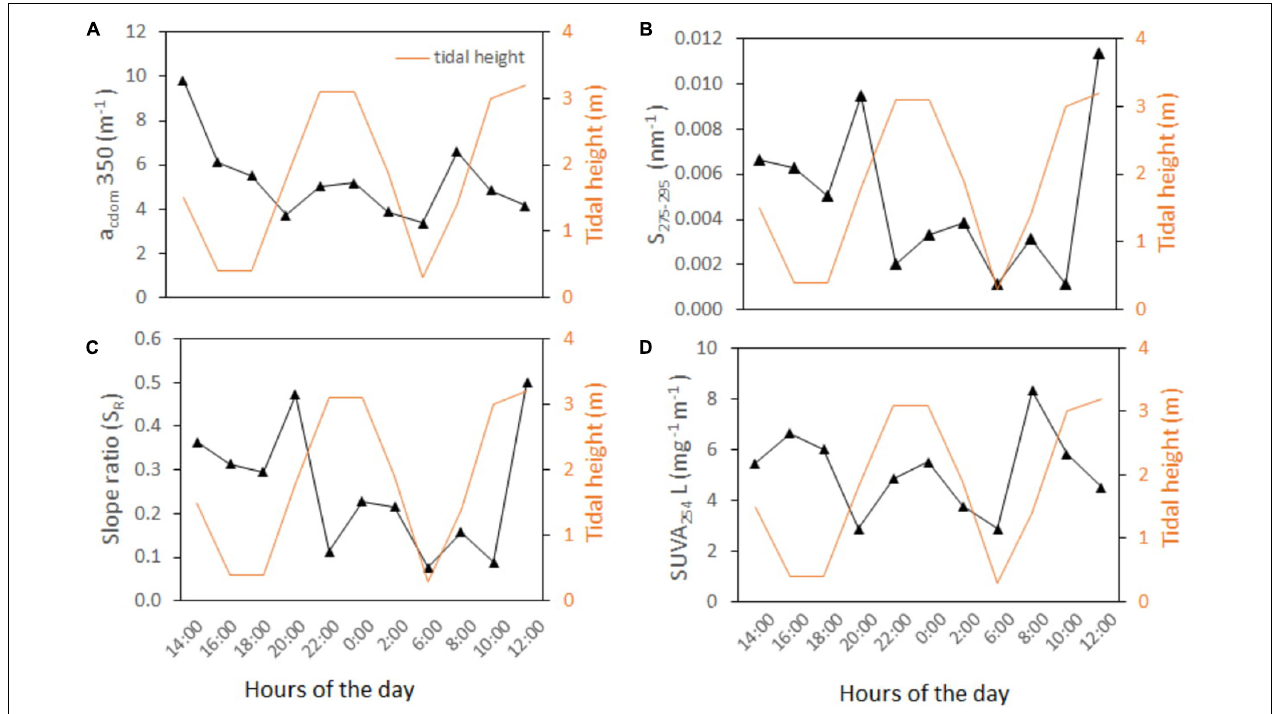
FIGURE 7 | Bi-hourly distribution of (A) a cdom (350) m − 1 , (B) slope at 275 and 295 nm, (C) slope ratio (SR) between 275–295 and 250–400 nm, and (D) SUVA 254 (L mg − 1 m − 1 ) during the 24-hr observation in the Saptamukhi estuary (point SM).